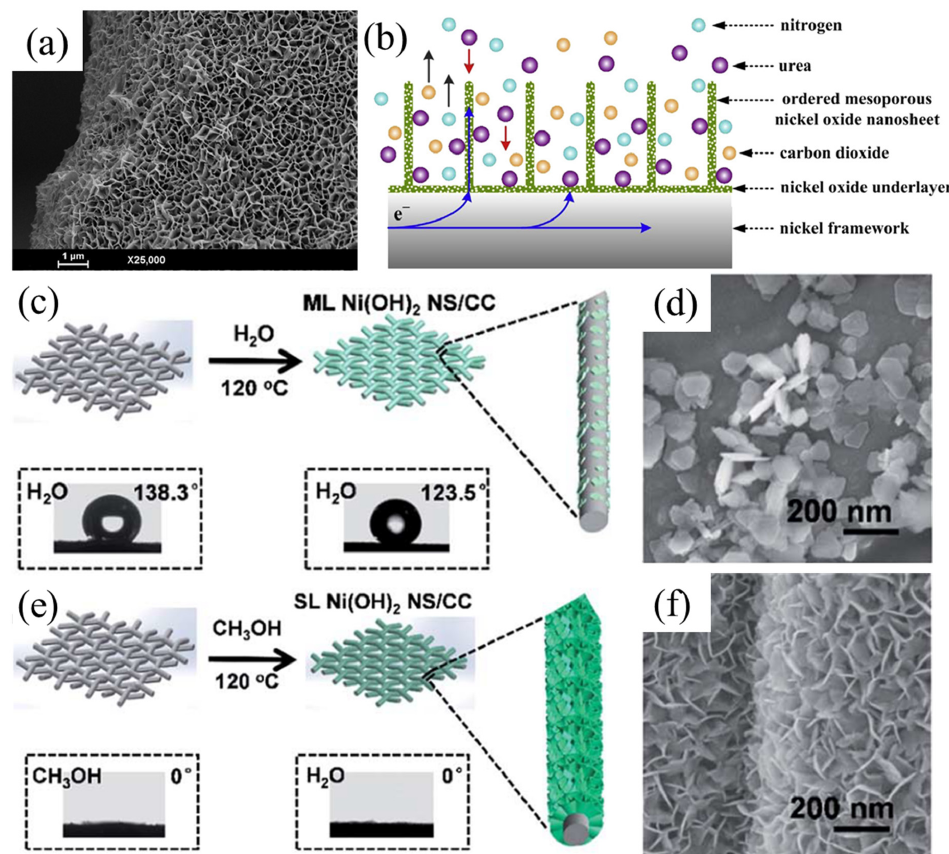
Figure 5. ( a ) SEM image and ( b ) illustration of vertically aligned NiO nanosheets in UOR application; ( c , e ) illustration of the synthetic process and ( d , f ) SEM image of ( c , d ) multilayer Ni(OH) 2 in water and ( e , f ) single layer Ni(OH) 2 in methanol solution. ( a , b ) Reprinted with permission from Ref. [35]. ( c – f ) Reprinted with permission from Ref. [37].